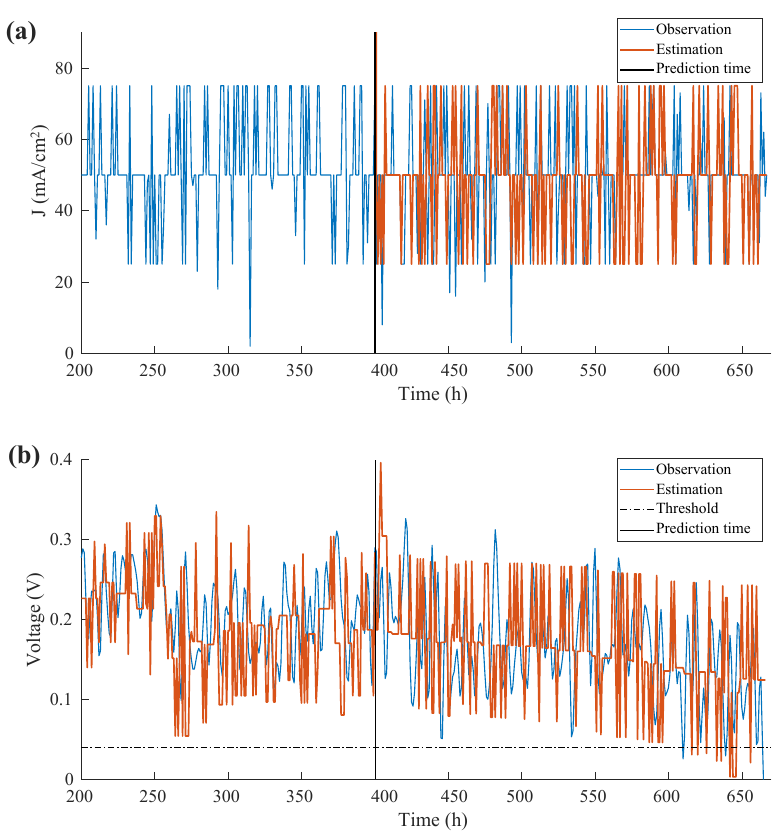
Figure 7. Prediction results: ( a ) Prediction of parameter I at t λ = 400 h; ( b ) Degradation Model-based RUL Prediction at t λ = 400